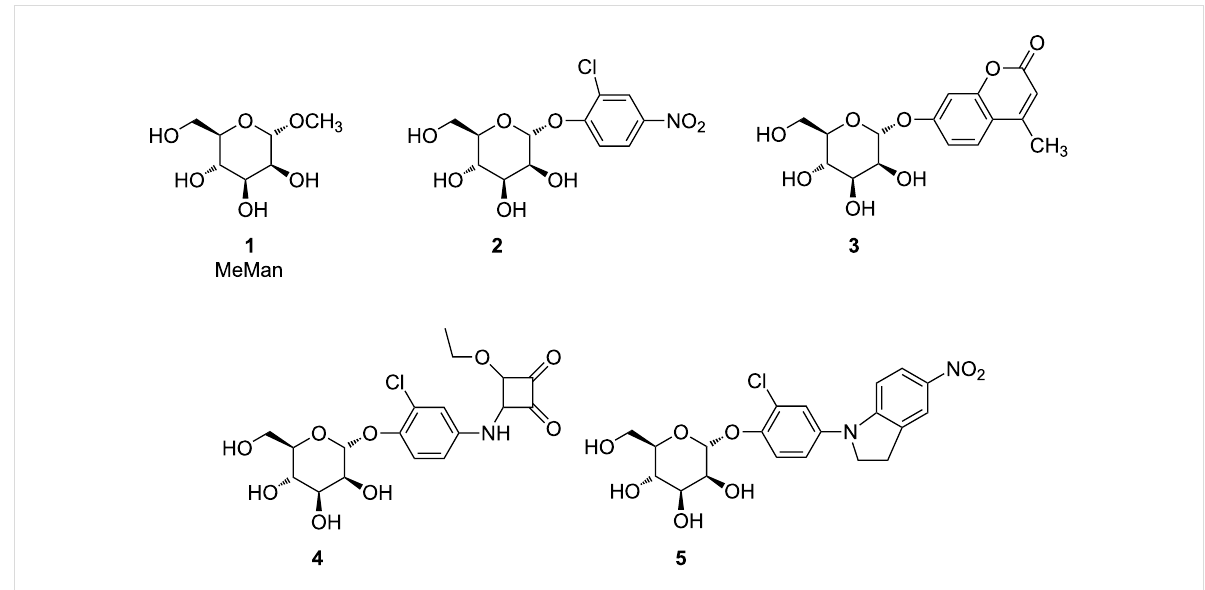
Figure 1: The bacterial lectin FimH is known to bind α -D-mannosides such as methyl α -D-mannoside 1 (MeMan) with IC 50 values in the millimolar range [4]. Based on MeMan ( 1 ), the affinity of the p NPMan derivative 2 is 717-times improved [13], that of the methylumbelliferyl mannoside 3 116 times improved [14], that of the squaric ester monoester 4 6900 times higher [15], and the indolinylphenyl mannoside 5 arrives at an IC 50 of 2.4 nM